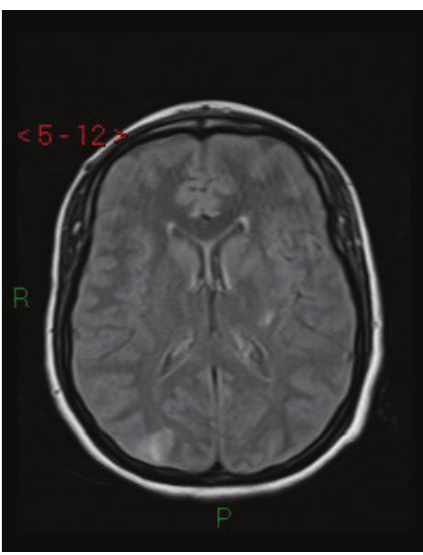
Figure 1: Case 1. Axial FLAIR MRI: cortical-subcortical hyperin- tense lesions in parietal-occipital regions and in the posterior lateral left putamen.